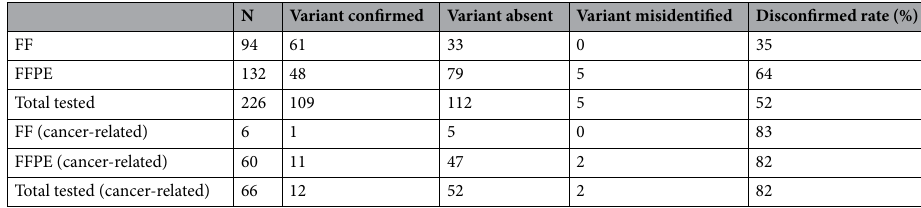
N Variant confirmed Variant absent Variant misidentified Disconfirmed rate (%)